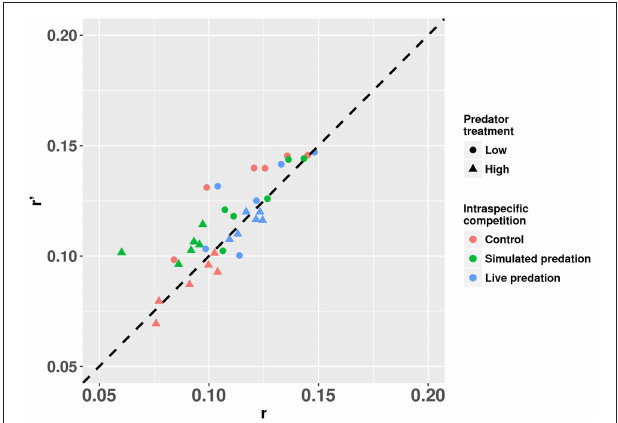
FIGURE 8 | Estimates of r’ (projected per capita rate of population change) plotted against r (per capita rate of population change estimated from the full life table) for cohorts of Aedes aegypti exposed to intraspecific competition and predation treatments. Values plotted are least squares means. The dotted 45 ◦ line through the origin represents the perfect concurrence between r’ and r . Values below and above the line represent underestimation and overestimation,